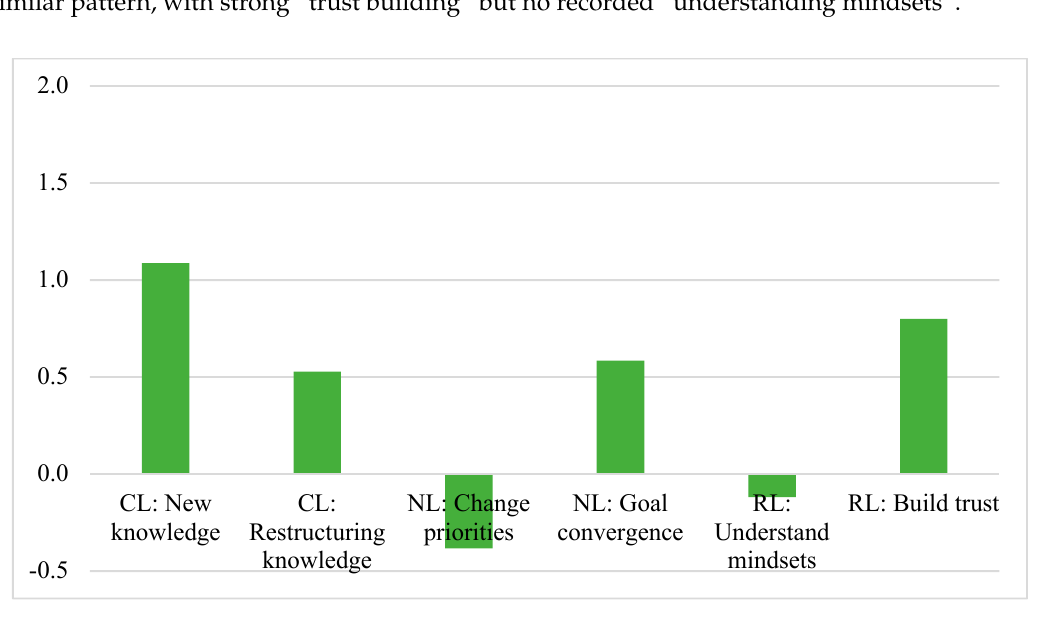
Figure 1. Mean scores for six measured learning variables across the entire experiment sample. High ≥ 1; medium = 0.5–1; low = 0–0.49; and none ≤ 0.